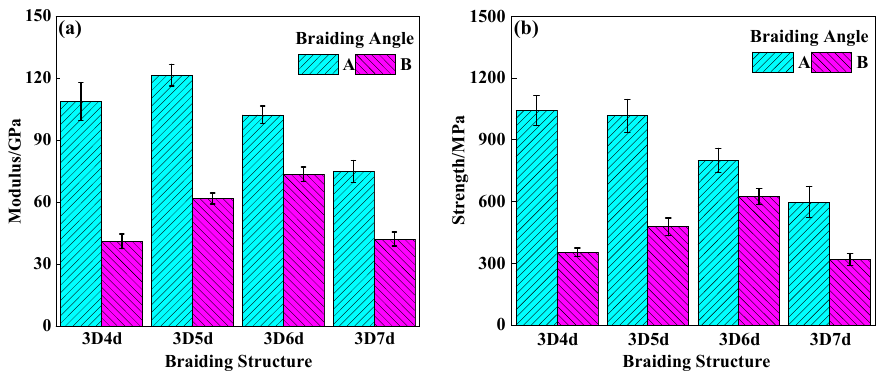
Figure 8. The tensile ( a ) modulus and ( b ) strength of 3DBC.